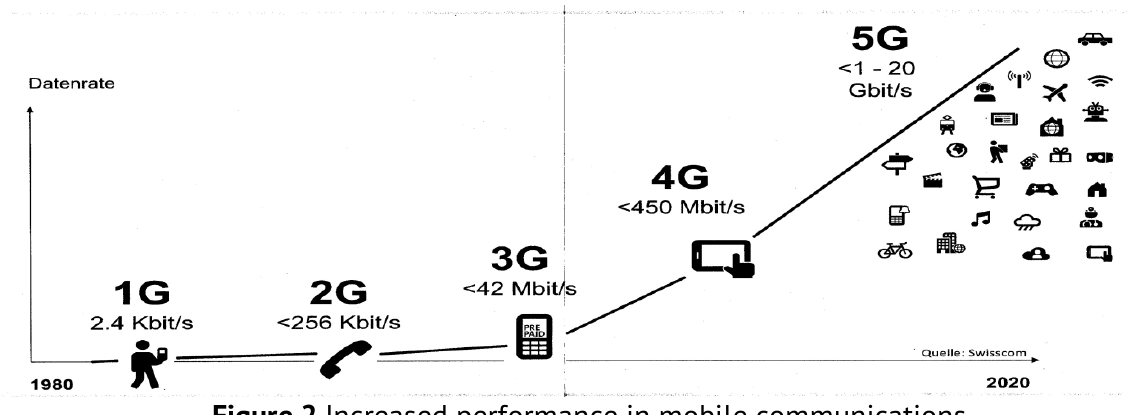
Figure 2 Increased performance in mobile